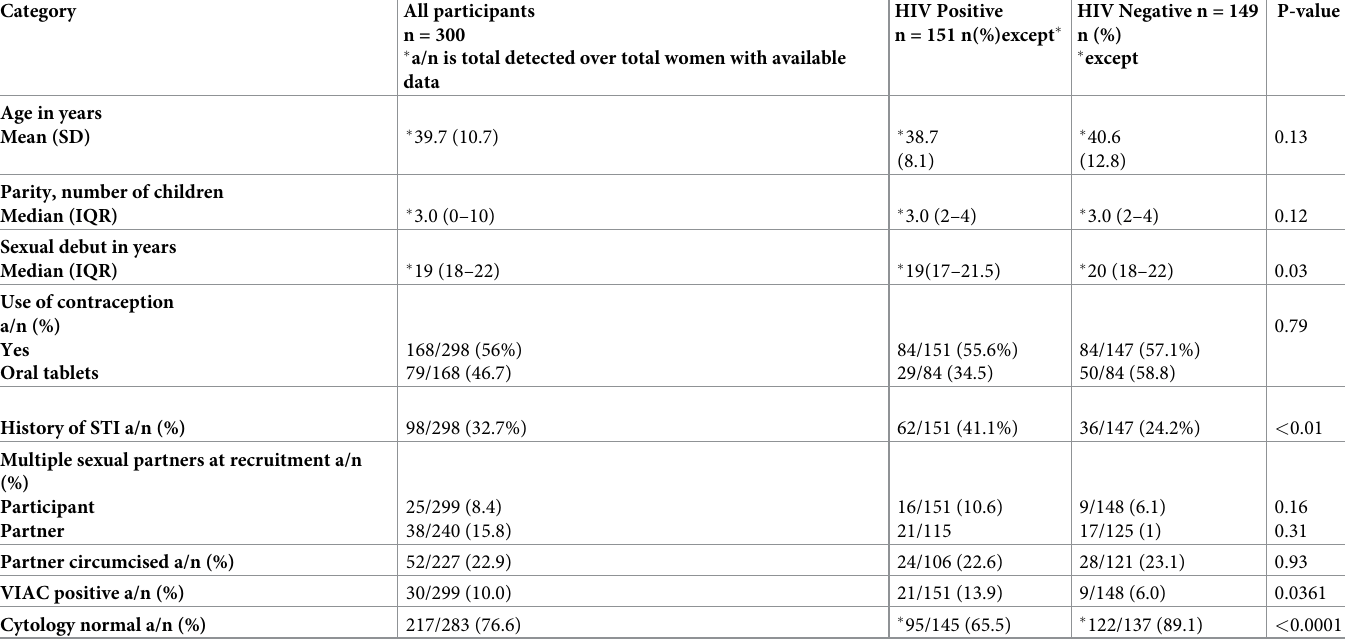
Table 2. Demographic and surveillance data of participants, grouped by their HIV